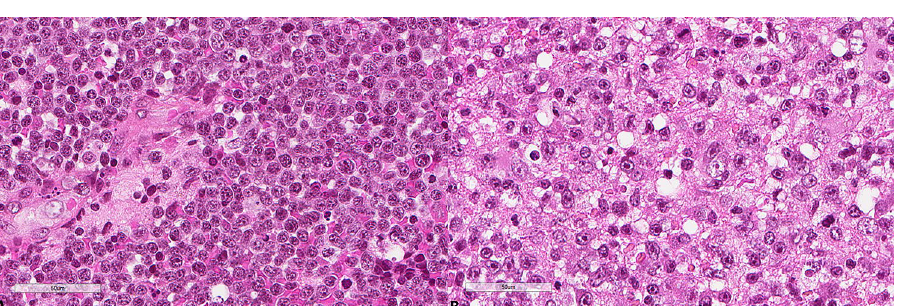
Figure 6. Representative morphological images. ( A ) Hematoxylin, eosin, safran section of the PCNSL shown in Fig. 5A (× 400). ( B ) Hematoxylin, eosin, safran section of the PCNSL shown in Fig. 5B (× 400).